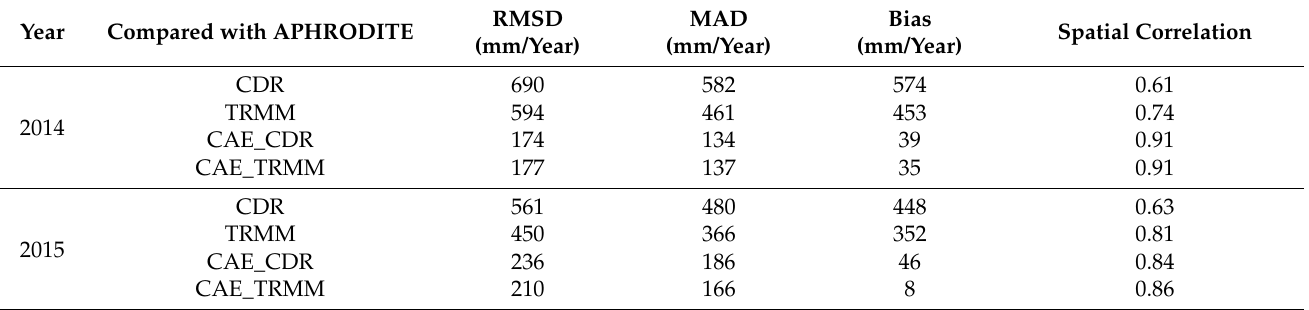
Table 3. Quantitative assessment of annual precipitation spatial correlation of